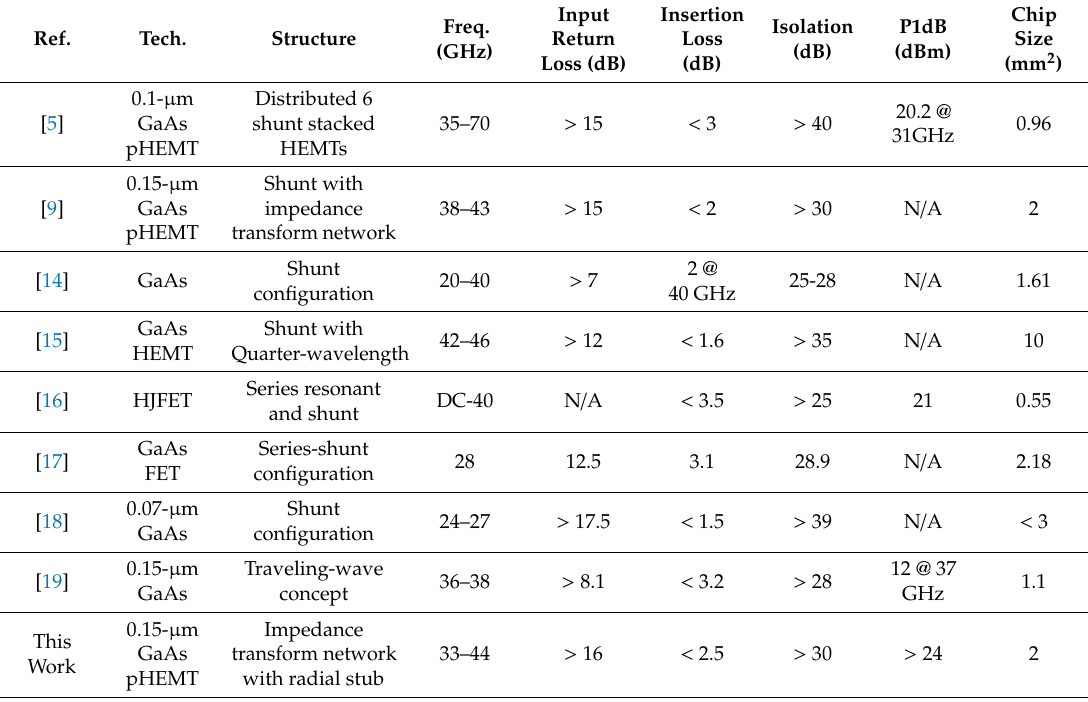
Table 1. Comparison of performance between proposed design and previous published works.